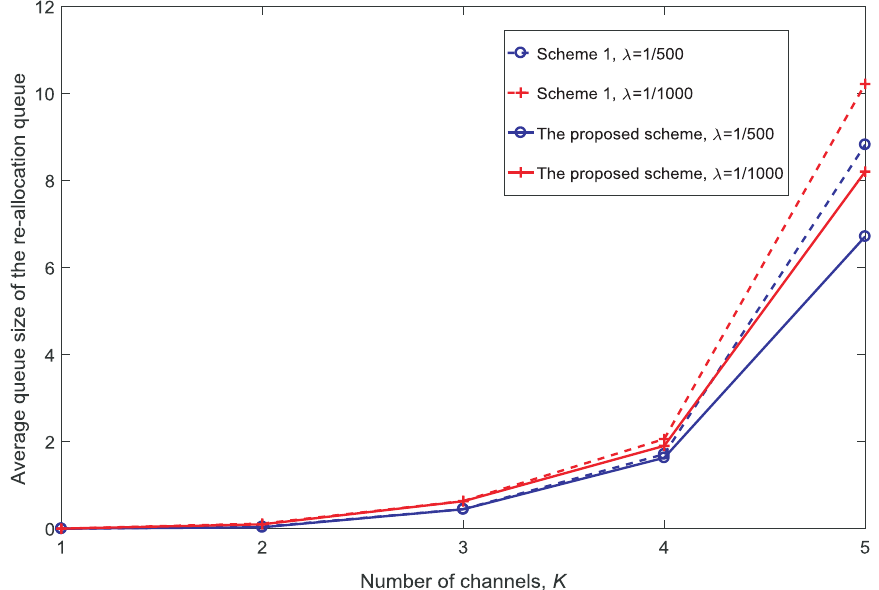
Figure 11. Average queue size of the re-allocation for different numbers of channels K ( d V = 10, V = 10, N = 5 )